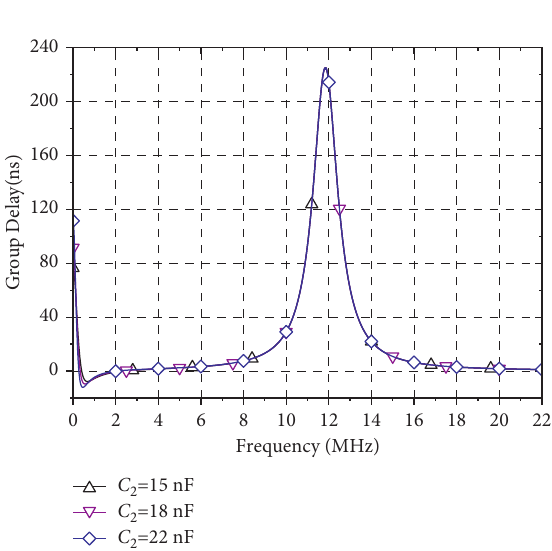
Figure 16: High-pass negative group delay in the band-stop filter passband.